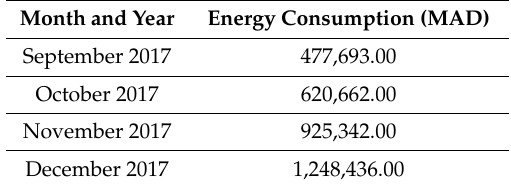
Table 1. Electricity consumption of the university during the fall semester of